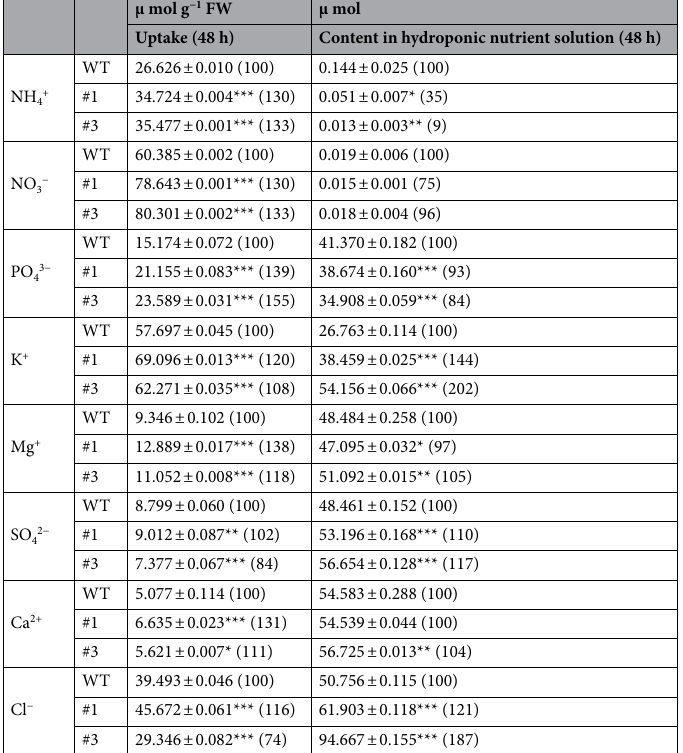
Table 1. Nutrient ion uptake and remaining nutrient ion content in the hydroponic nutrient solution at 48 h after replacement with the fresh hydroponic nutrient solution in the WT, and R1 -Cas #1 as well as #3 plants at the 5-leaf stage. Data are represented as the average ± standard error of the mean ( n = 4). Asterisks indicate significant differences relative to the WT plants based on the Student’s t -test (* P < 0.05, ** P < 0.01 and *** P < 0.001). Values relative to those of WT as 100 are shown in